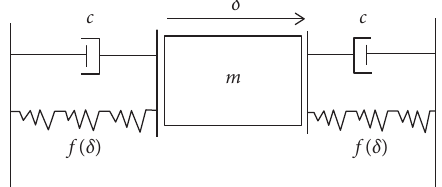
Figure 1: The proposed vibration model for transport